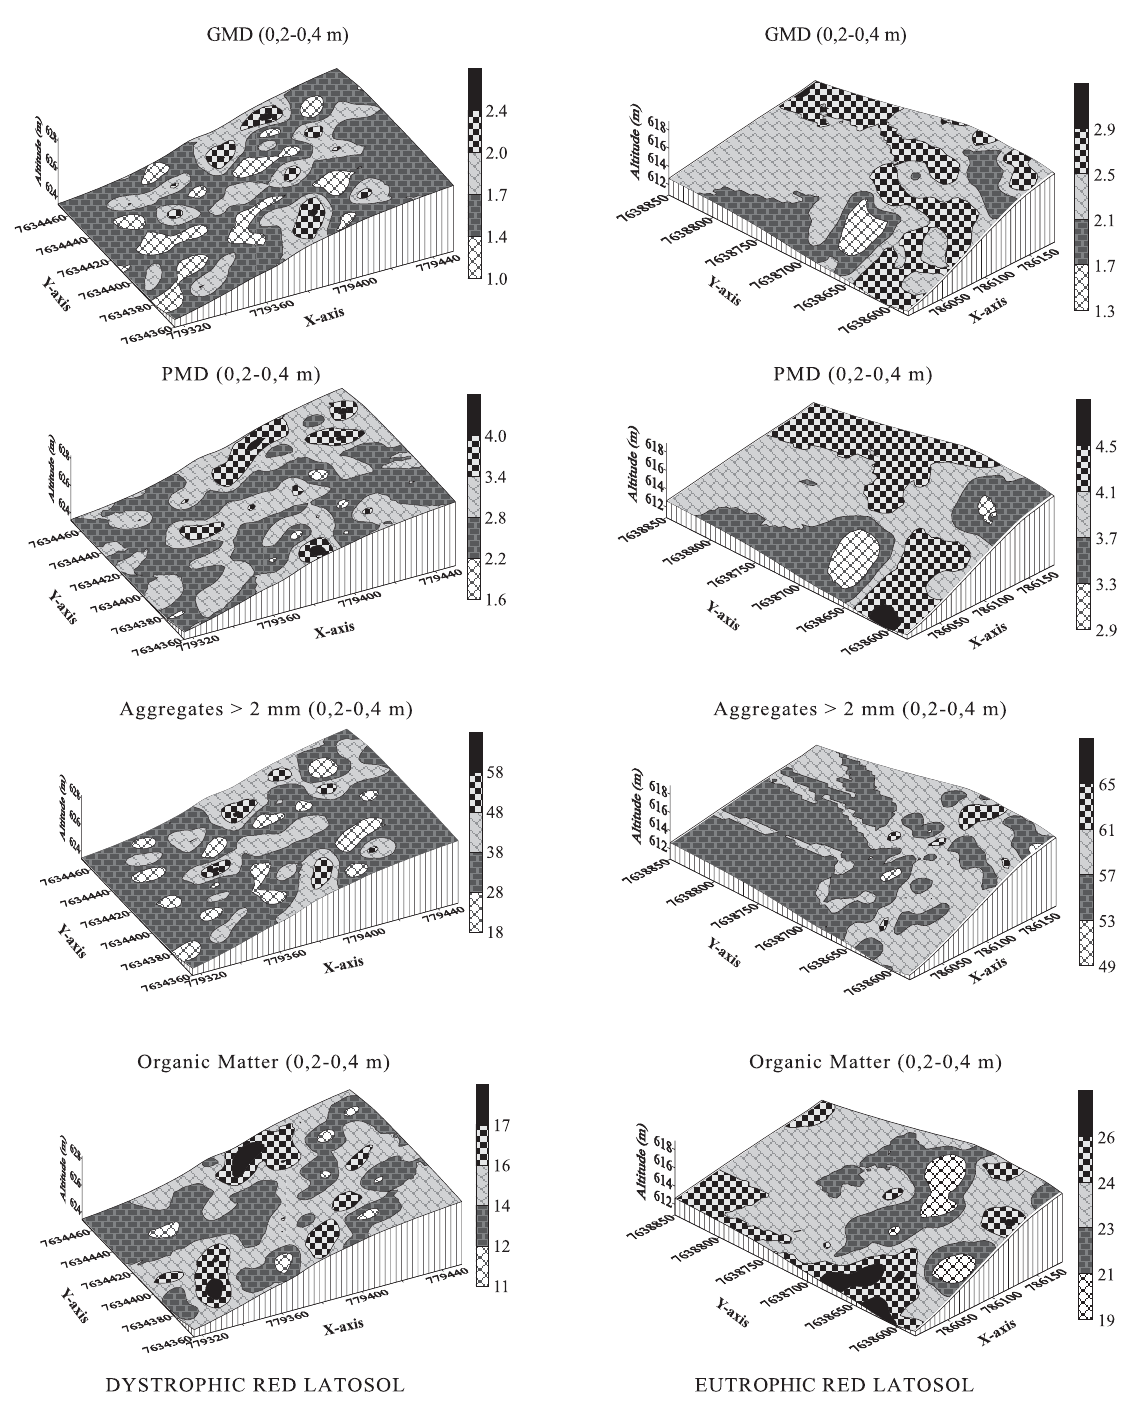
Figure 3. Spatial distribution of the variables geometric mean diameter (mm), mean weight diameter (mm), aggregates in class > 2.0 mm (%) and organic matter proportion (g dm -3 ), in an eutrophic Red Latosol (ERL) and a dystrophic Red Latosol (DRL) in 0.2–0.4 m